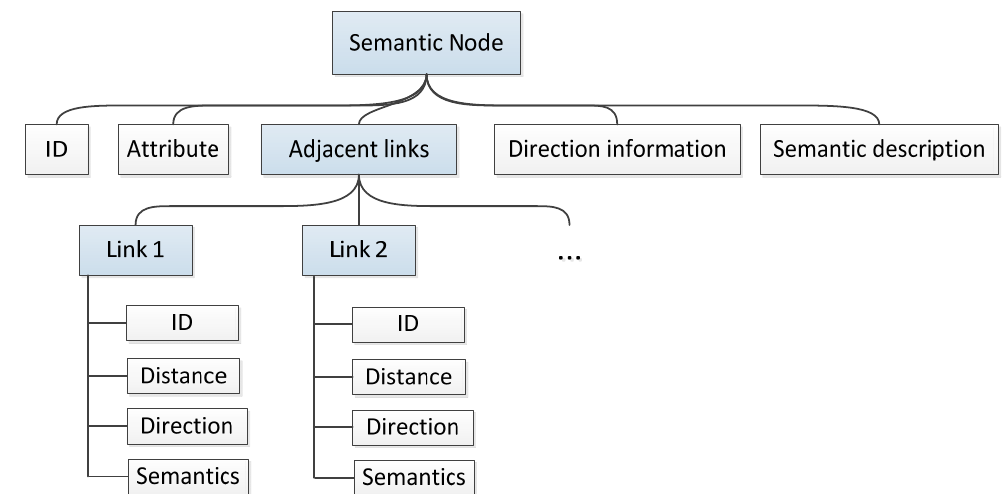
Figure 2. The semantic-rich link-node model.